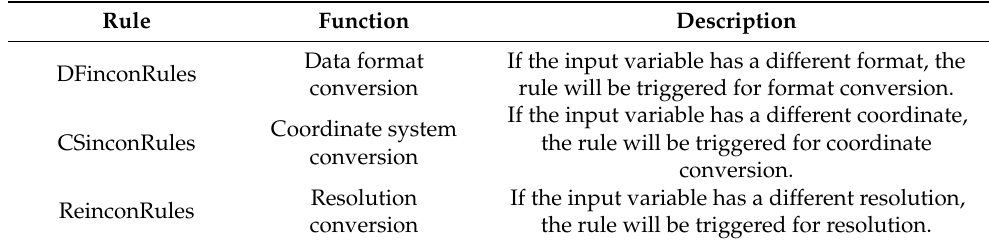
Table 2. SWRL matching rules and their